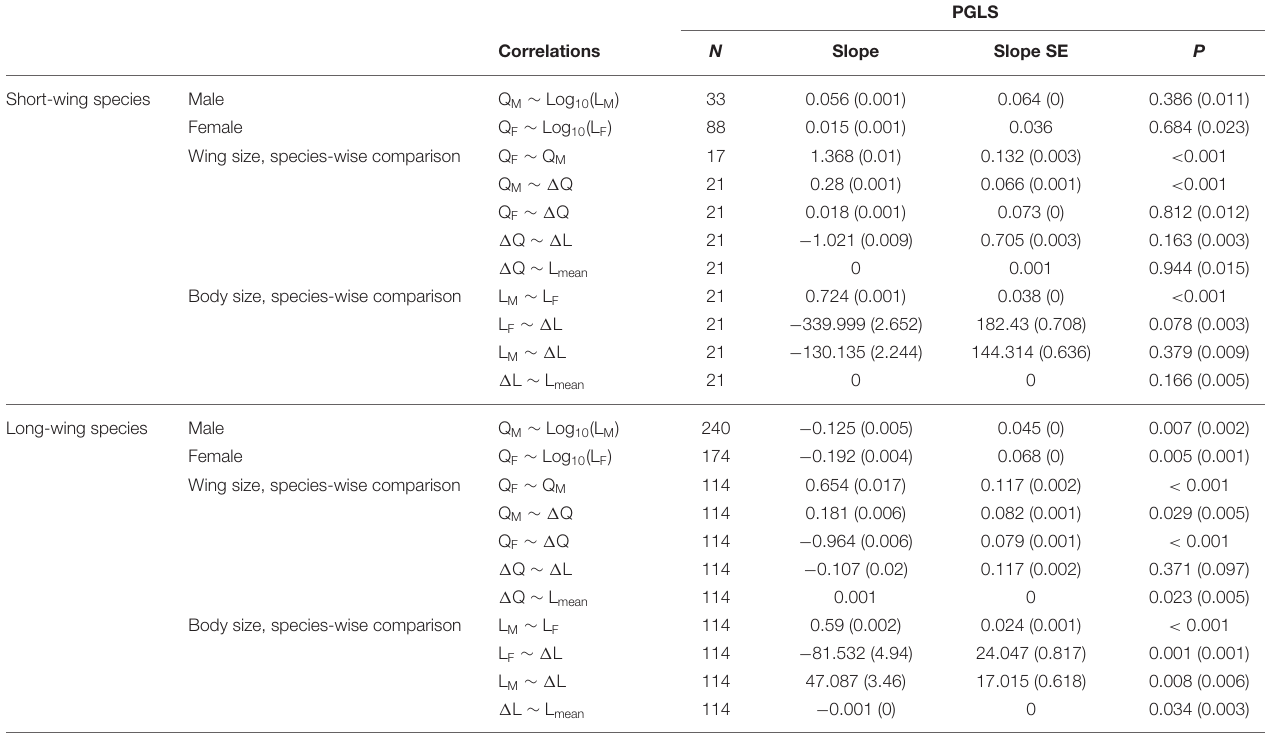
Values represent means from analyses using 100 randomly resolved trees, with 1s.d. in